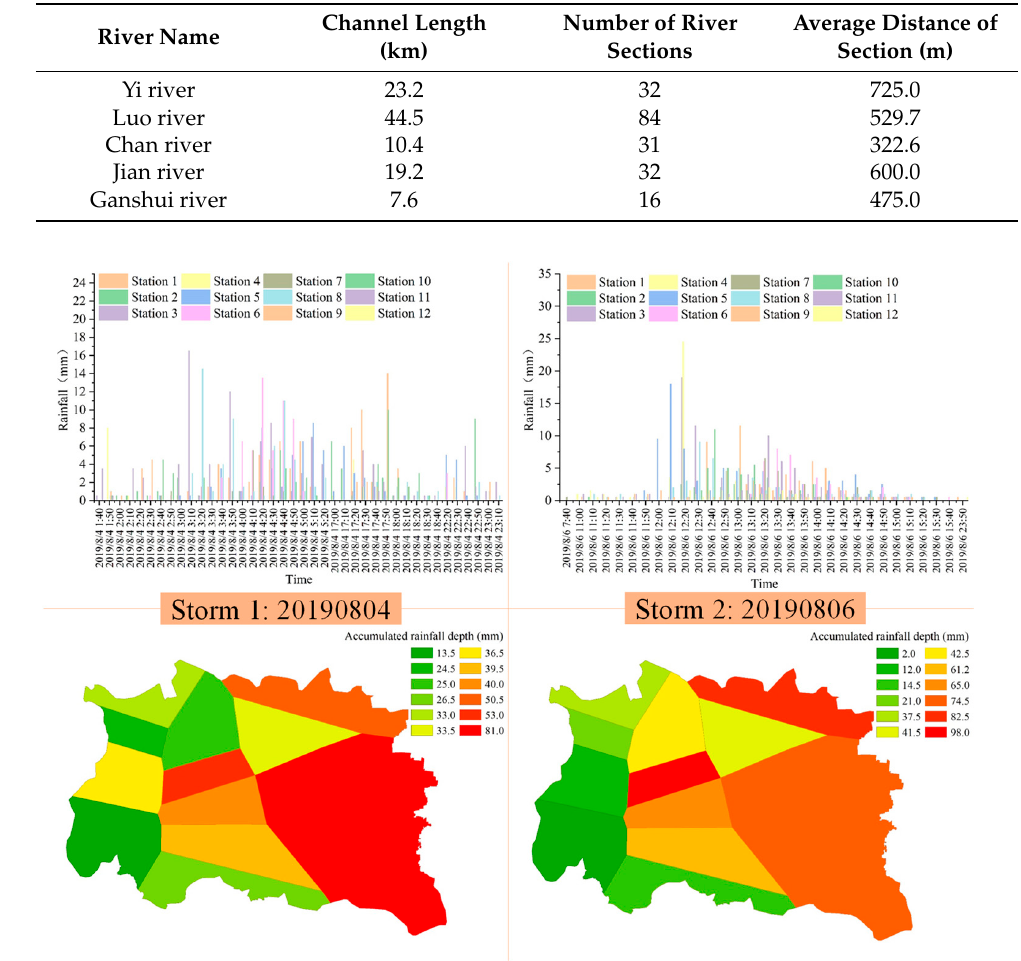
Table 1. Basic information of Yi, Luo, Chan, Jian and Ganshui rivers.